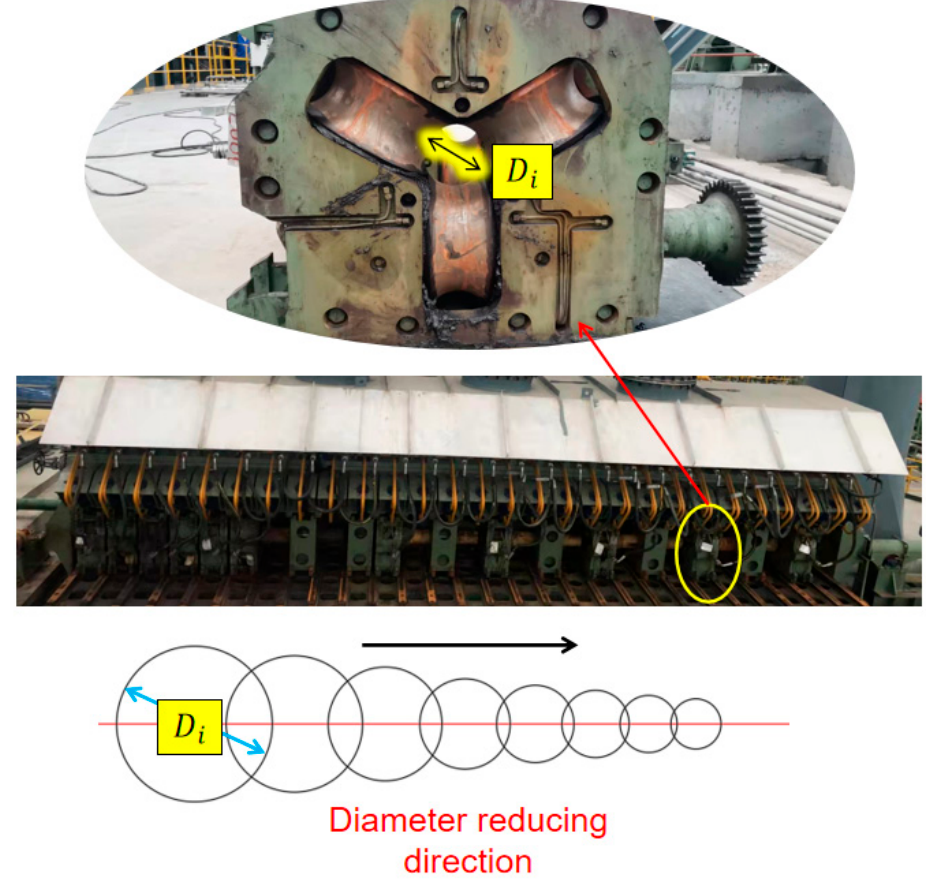
Figure 1. Device diagram of three-roll stretch reducing.